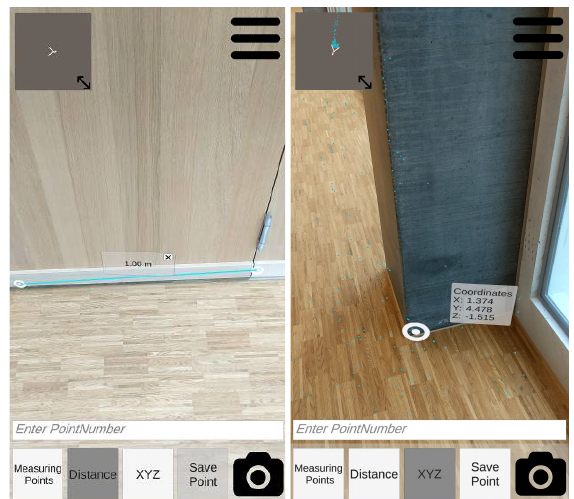
Figure 1. AR application: Measuring functionalities (left: distance, right left: point